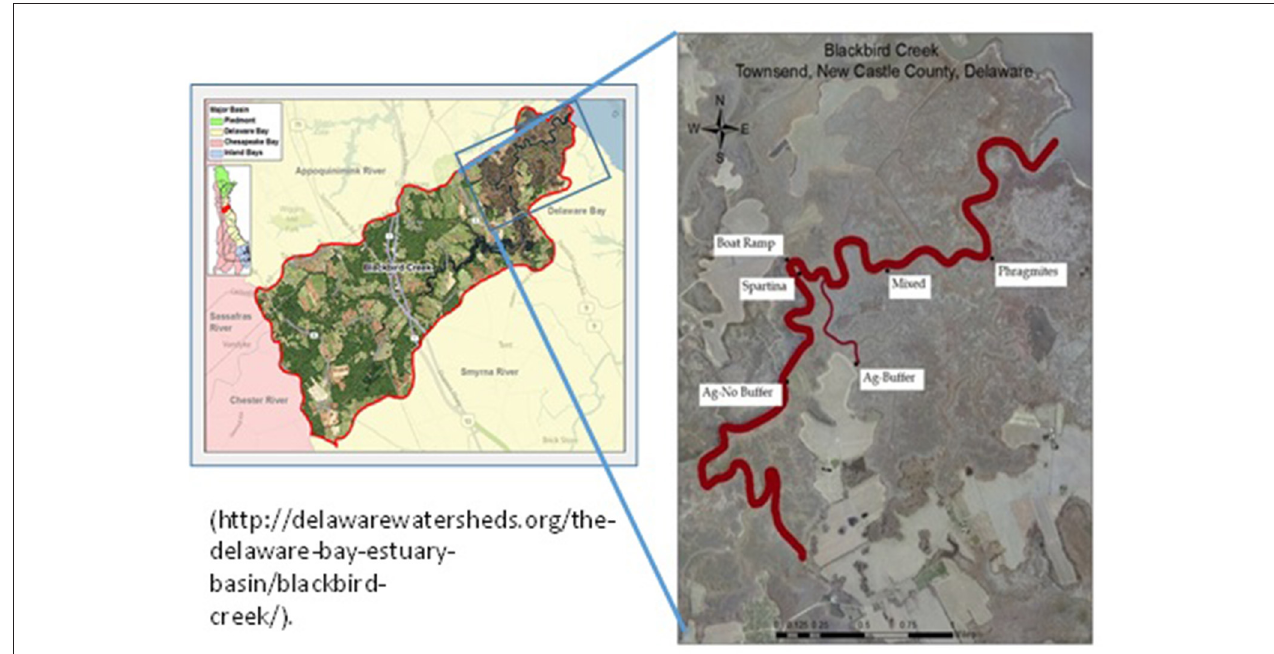
FIGURE 1 | Soil and water sampling sites in the Blackbird Creek, Townsend, Delaware Phragmites - (P); mixed site (M); agriculture (Ag-B); boat ramp (BR); Spartina (S); agriculture site without buffer (Ag-NB). First map is from DNREC website.